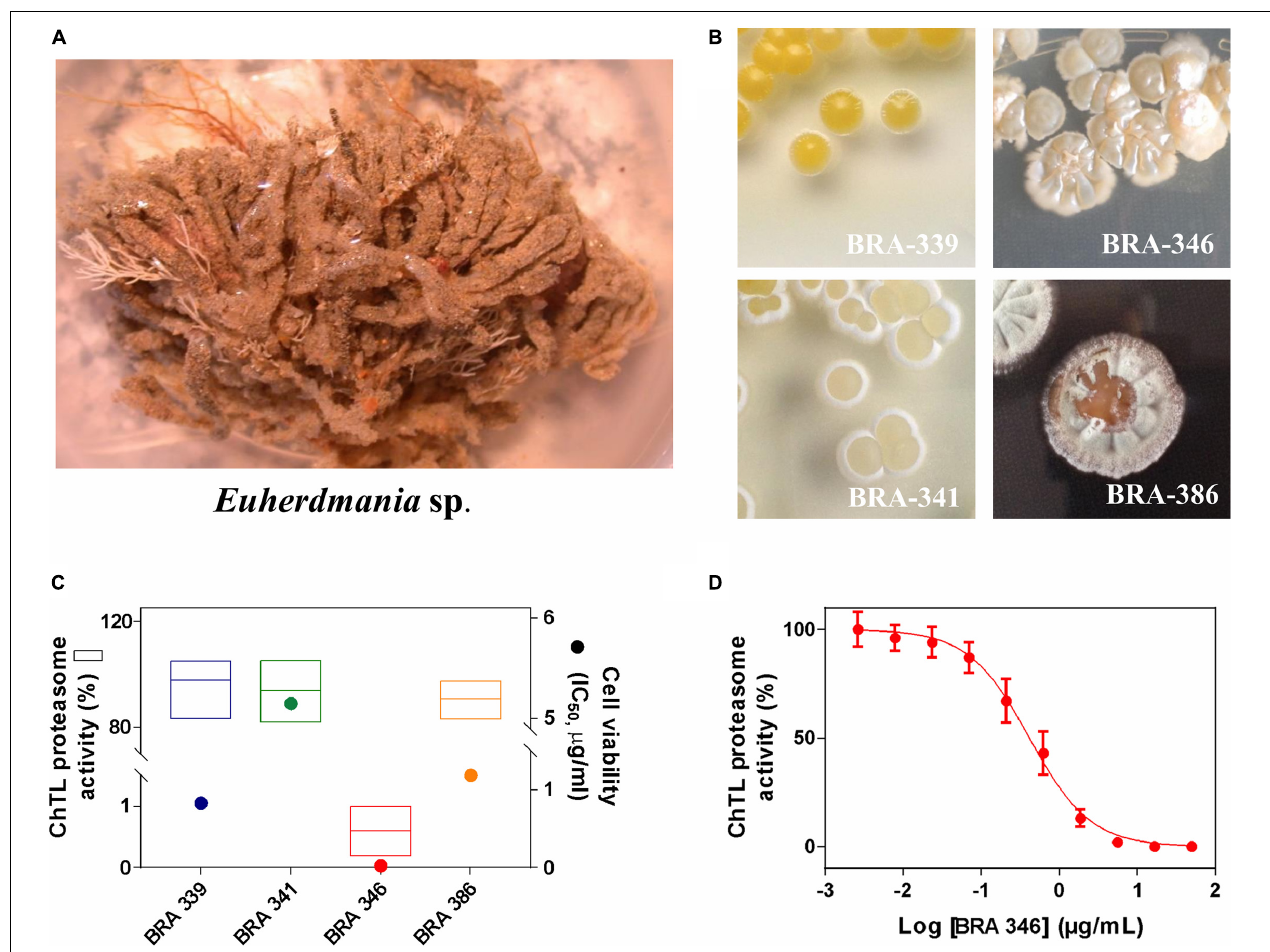
FIGURE 1 | (A) Photo of the ascidian Euherdmania sp. collected on the northeast coast of Brazil. (B) Photographs of Euherdmania sp. associated bacteria: BRA-339, BRA-341, BRA-346 and BRA-386. (C) Graph showing the chymotrypsin-like (ChTL) enzymatic activity of proteasome purified from Saccharomyces cerevisiae (1 µ g/mL) after 2 h of incubation with bacterial extracts at 50 µ g/mL (left axis; n = 3) and IC 50 values of the bacterial extracts against HCT-116 cell line assessed by MTT assay after 72 h of incubation (right axis; n = 3, in concentrations ranging from 0.0032 to 50 µ g/mL). (D) Concentration-response curve of BRA-346 extract on the ChTL enzymatic (IC 50 = 0.42 µ g/mL) activity. The ChTL substrate (LLVY-AMC) was set at a concentration of 40 µ M.